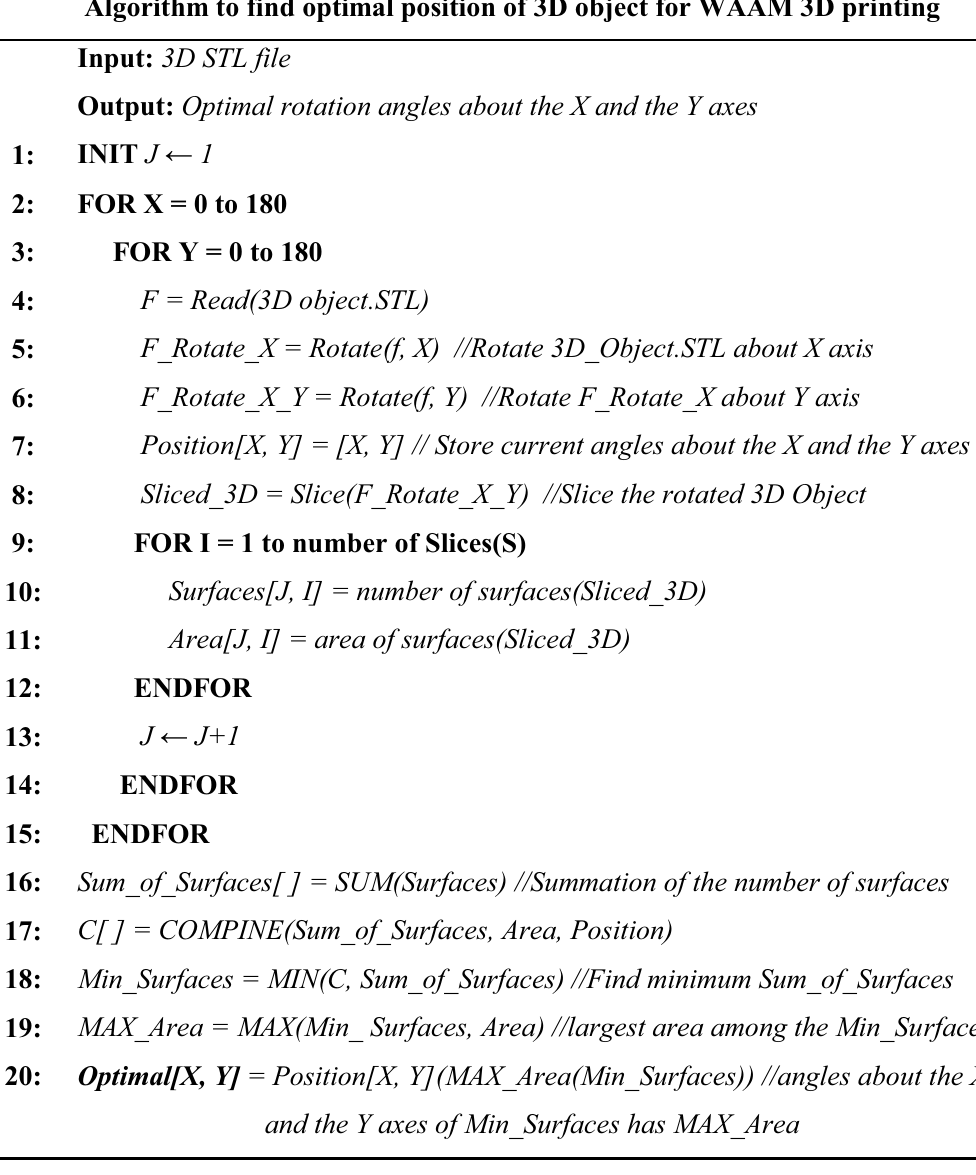
Table 1. Algorithm.